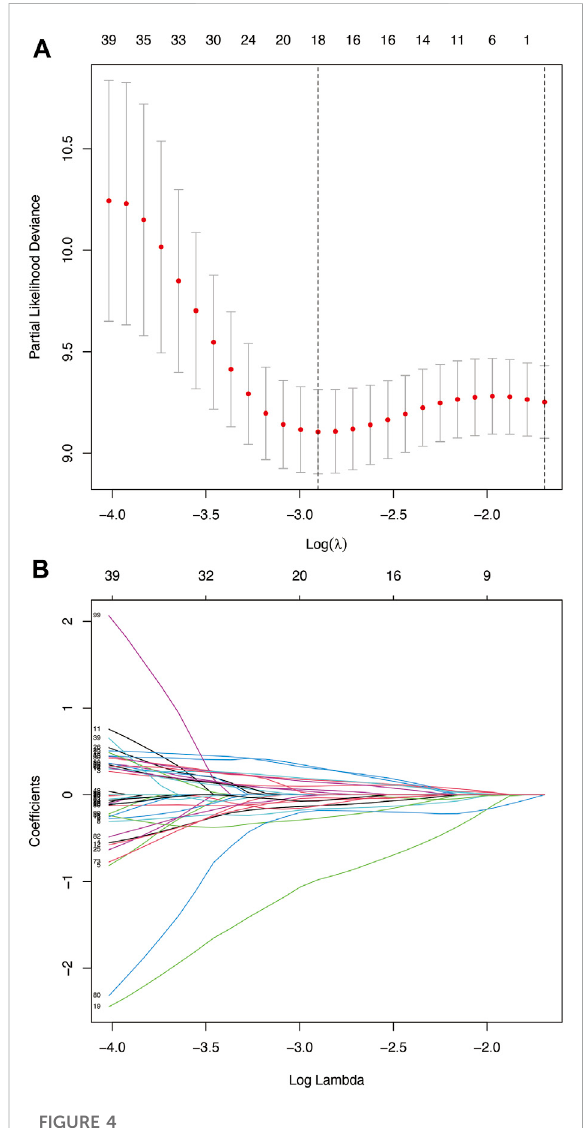
FIGURE 4 (A) Deviance plot of partial likelihood by LASSO Cox regression analysis. Red dots: the partial likelihood of deviance values;graylines:thestandarderror(SE);verticaldottedlineonthe left: the optimal values by minimum criteria; vertical dotted line on the right: 1 − SE criteria. (B) LASSO coef fi cient pro fi les of the 121 TME-related genes in